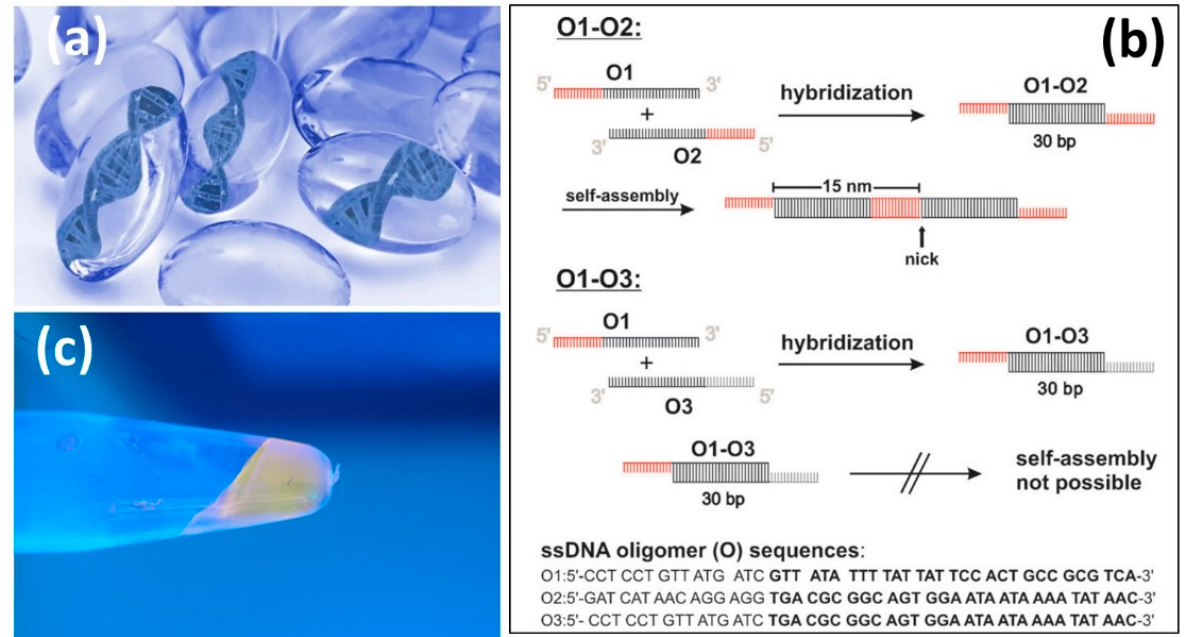
Figure 1. ( a ) DNA based hydrogels. DNA can be used as the sole component of a hydrogel. It can act as the backbone or a cross-linking agent connecting active molecules to the hydrogel via chemical reactions or physical entanglement. ( b ) A typical DNA hydrogel formation mechanism known as oligomer hybridization. By hybridization of O1 with O2, a double-stranded DNA monomer (O1-O2, 30 base pairs and 15 base sticky ends) is generated, which can self-assemble. The double-stranded DNA monomer O1-O3 (30 base pairs) comprises non-complementary 15-base overhangs and cannot further self-assemble. ( c ) Optical micrograph of a DNA hydrogel produced from the oligomers O1 and O2. The DNA hydrogel was stained with CybrSafe ® DNA dye and illuminated with UV light ( λ max = 366 nm). Reproduced from [2,6] with permission.